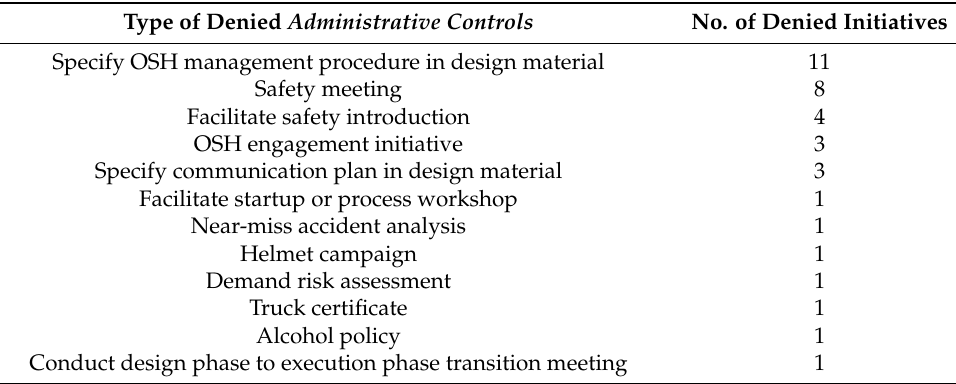
Table 6. Subcategories of denied administrative controls